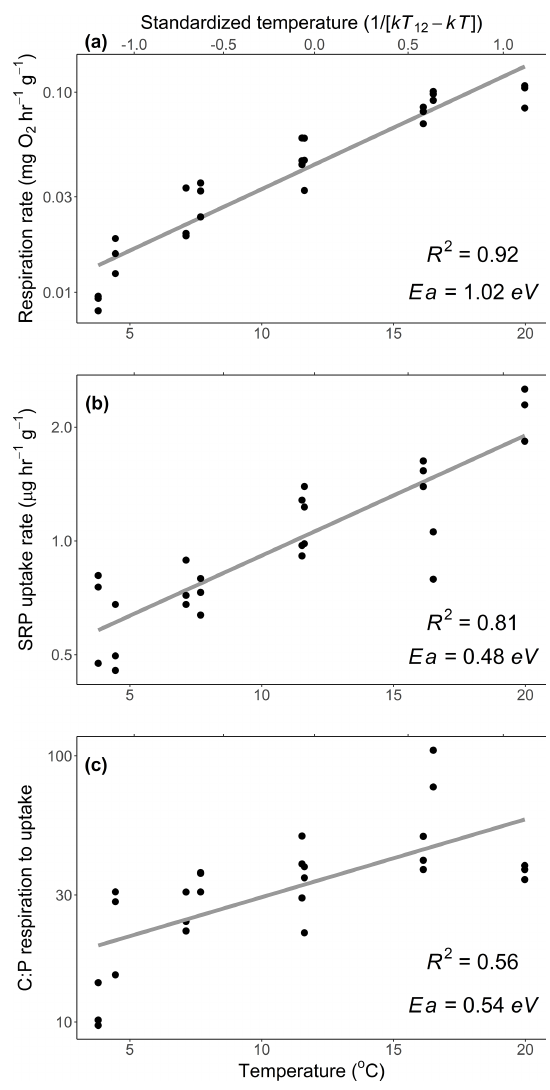
Figure 1. Mass-specific respiration (a) and soluble reactive phos- phorus (SRP) uptake rates (b) of Rhododendron maximum leaves with temperature and (c) the molar ratio of C respired to P uptake across different temperatures. Standardized Boltzmann temperature is presented on the secondary x axis. Points represent measurements from replicate bottles and gray lines represent best fits. Slopes of lines represent activation energies ( E a ) , which are reported in units of electron volt. Note y axes are log 10 -scaled. See Table 2 (experi- ment 1) for information on model fit, slopes, and